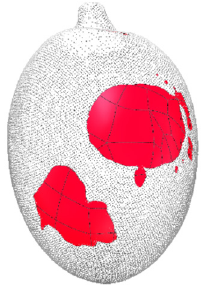
Figure 10. Boolean operation